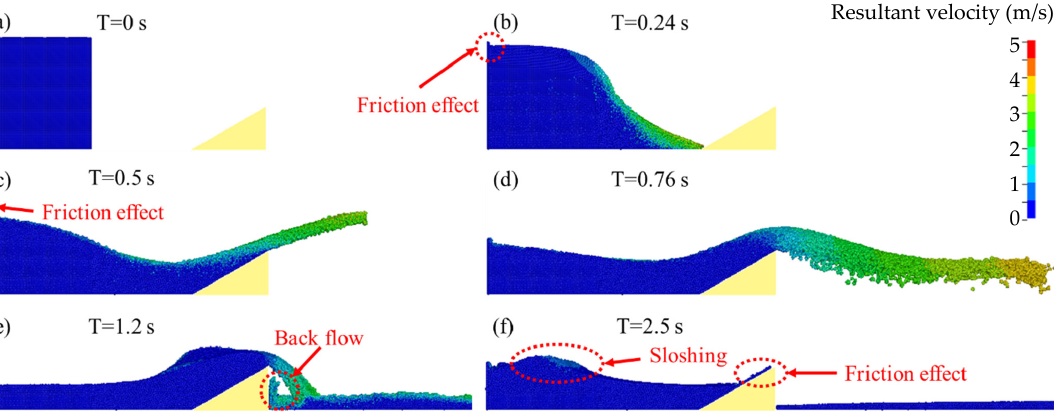
Figure 4. Flow states of the tailings particles at (a) T = 0 s, (b) T = 24 s, (c) T = 0.5 s, (d) T = 0.76 s, (e) T = 1.2 s, and (f) T = 2.5 s starting from the breach of the tailings dam; simulation with a catch dam having an upstream slope angle of 30°.